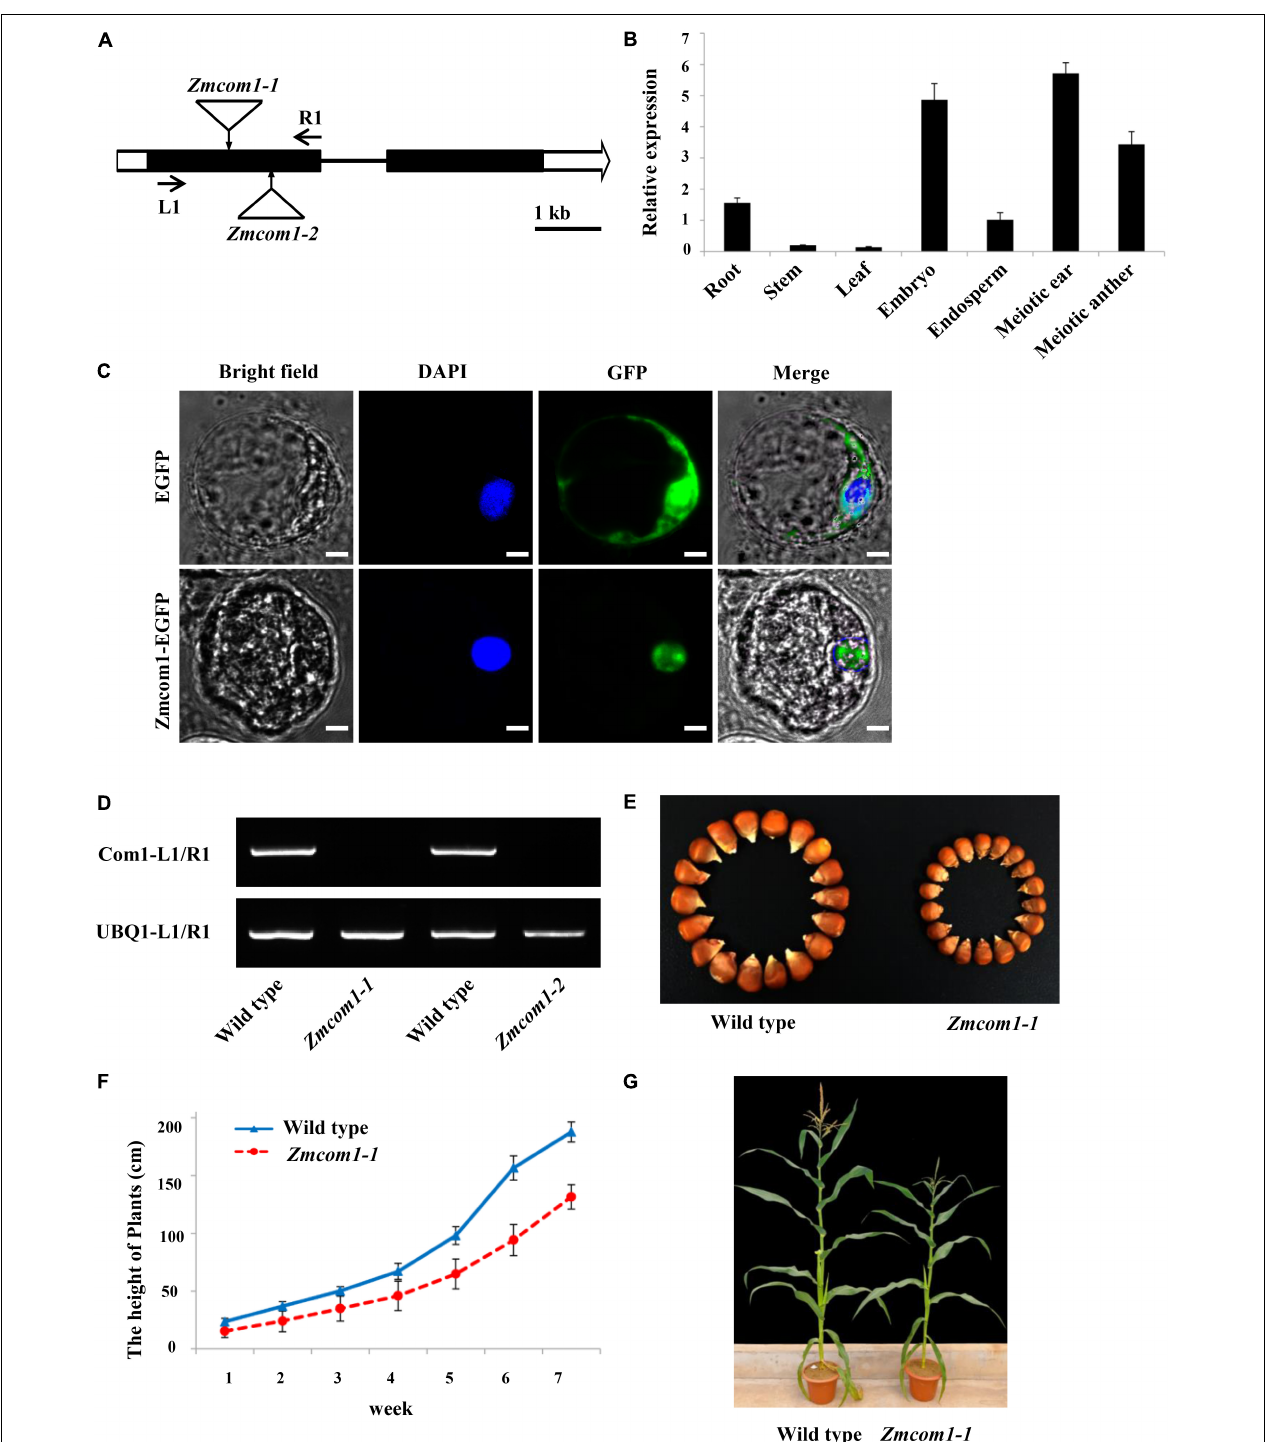
FIGURE 1 | Characterization of the ZmCom1 gene. (A) Diagram of genomic structures of the ZmCom1 genes with Mutator transposon insertion sites marked with triangles. Bars indicate exons and lines represent introns. Scale bar = 1 kb. (B) RT-qPCR analysis of ZmCom1 transcription in different tissues. Expression levels relative to the expression level of the UBQ1 gene are presented with standard errors. Values are means of three independent experiments. (C) ZmCom1 protein is localized to nucleus in maize protoplasts. Scale bar = 5 µ m. (D) RT-PCR analysis of ZmCom1 transcript in different genotypes. The maize UBQ1 gene was used as an internal control. (E) Morphological comparison of mature seeds between wild type and Zmcom1-1 mutant. (F) Growth-curve of plant height in wild type and zmcom1-1 mutant plants. Values are means of 10 individual plants. (G) Morphological comparison of mature plants between wild type and Zmcom1-1 mutant.